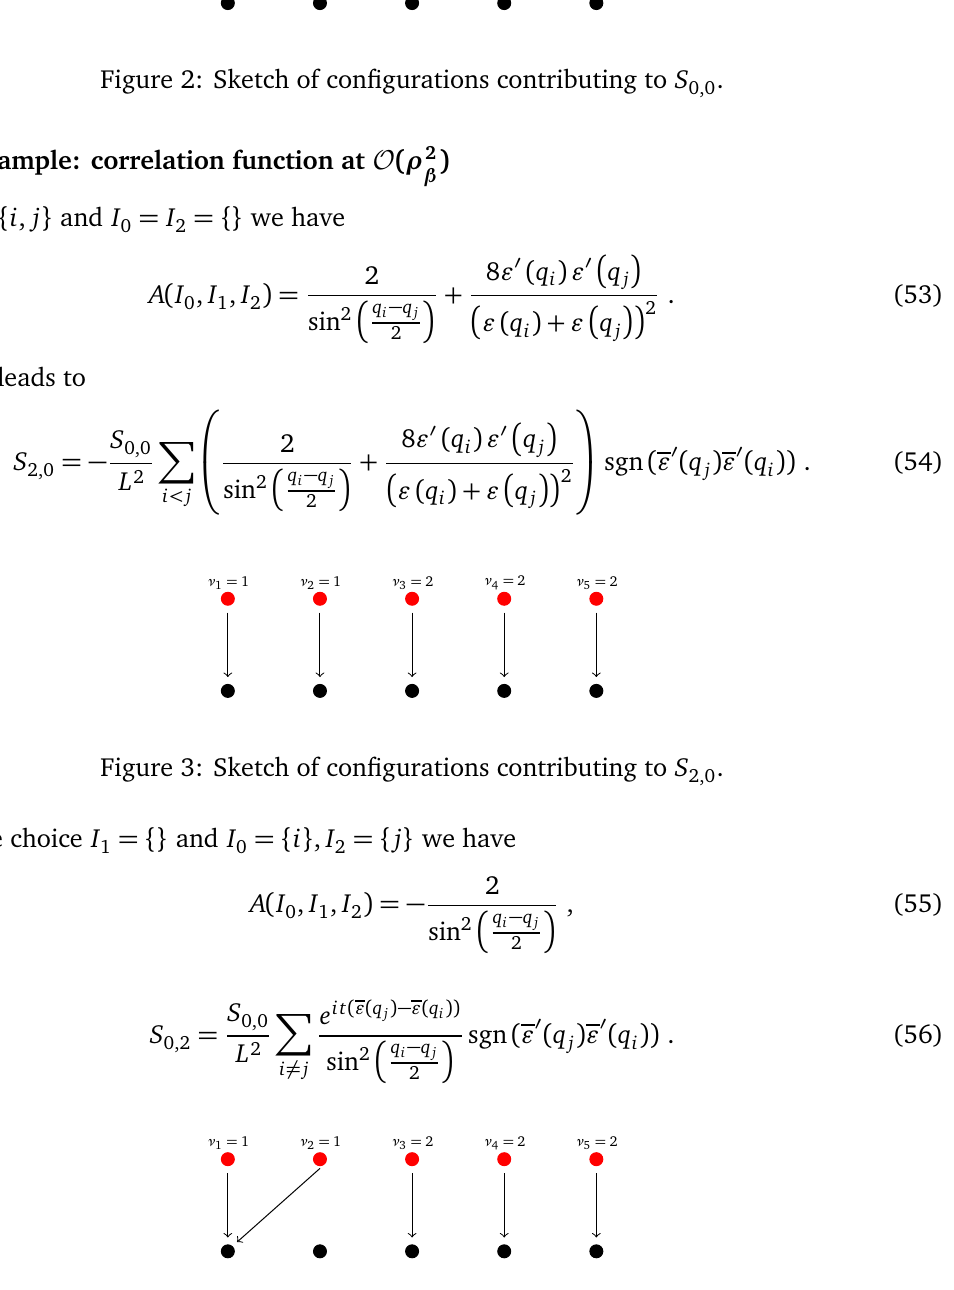
Figure 4: Sketch of configurations contributing to S